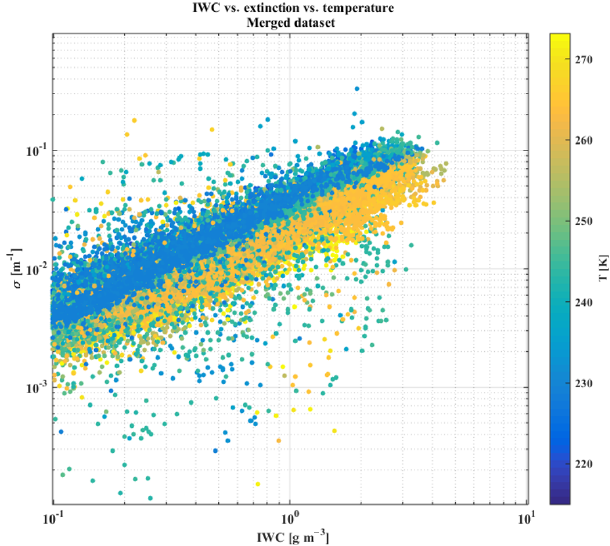
Figure 19. Visible extinction in m − 1 on the y axis as a function of IWC in kgm − 3 on the x axis and as a function of T in K indi- cated by the color scale. Scatter plot using the merged dataset (four